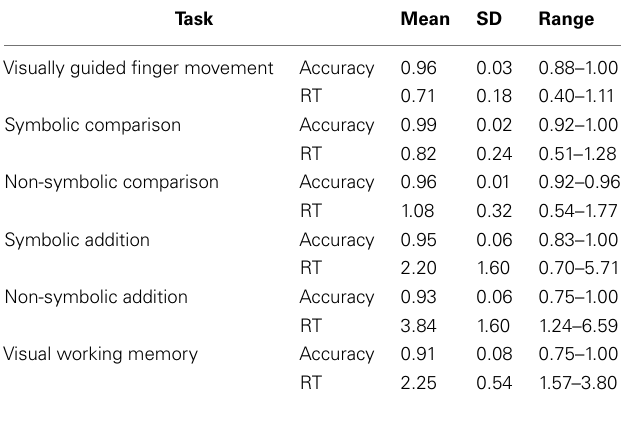
Table 1 | Descriptive statistics of behavioral results (reaction times in seconds).